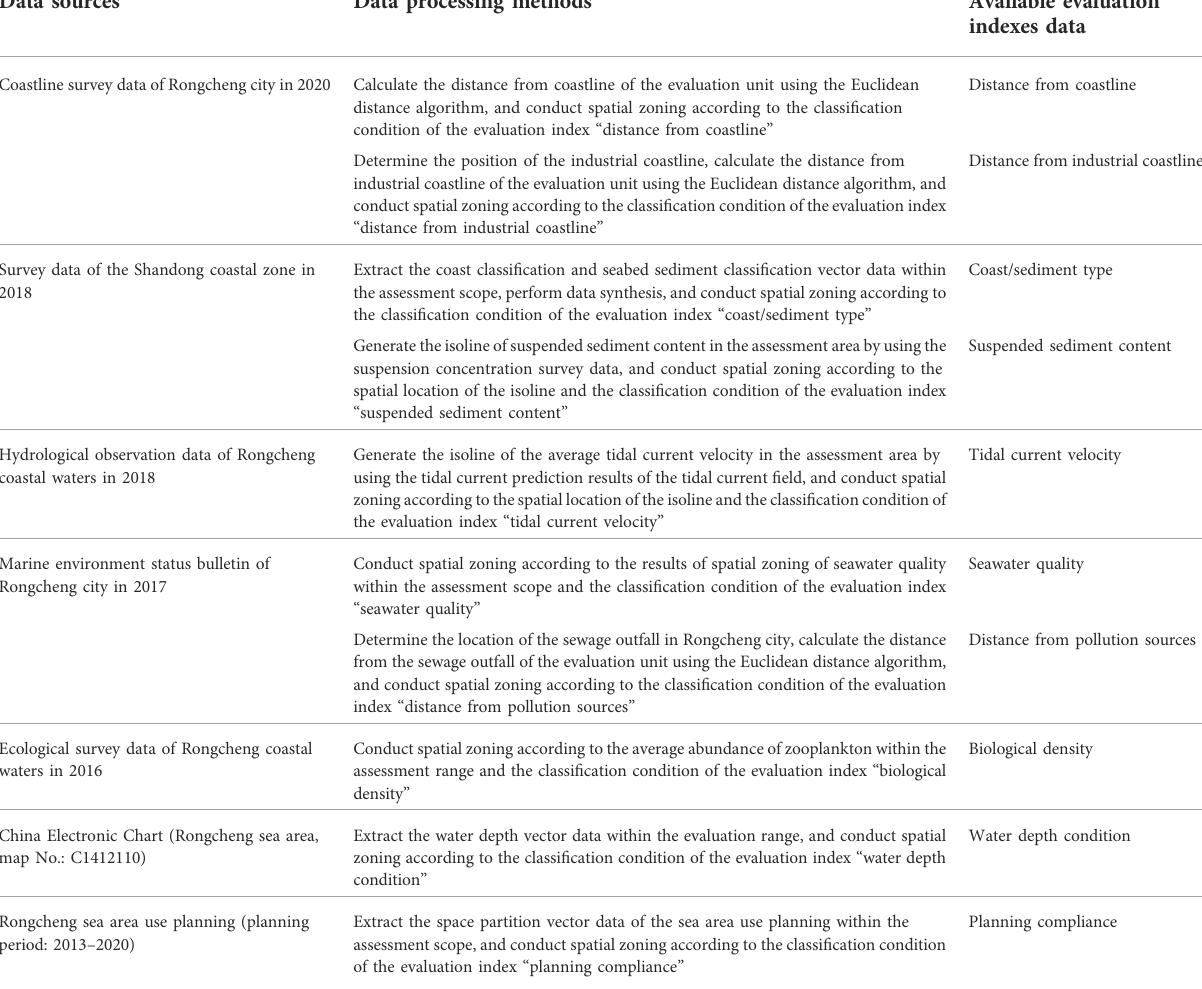
TABLE 4 Data sources and processing